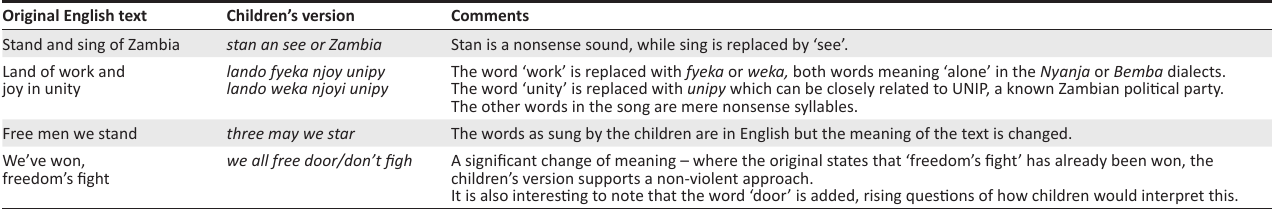
TABLE 1: Example of children’s version of the Zambian national anthem. Original English